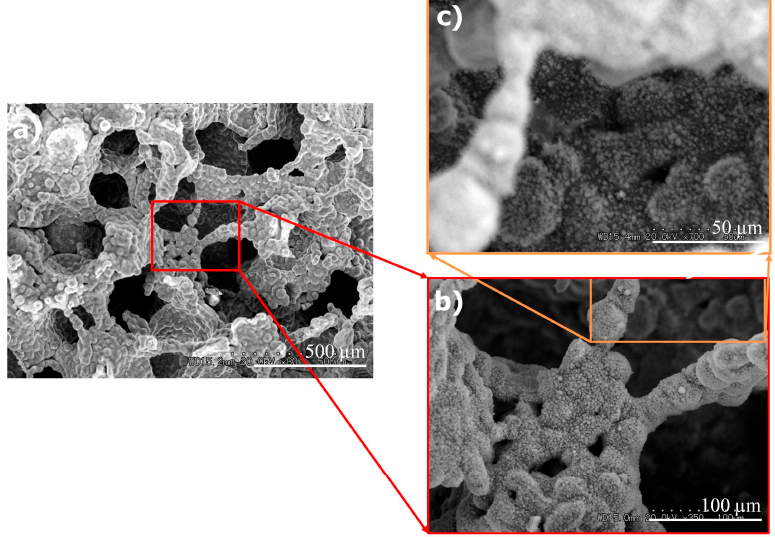
Figure 4. Scanning electron microscopy (SEM) images of Porous ‐ Ti ‐ AT ‐ SPT. Fine spherical hydroxyapatite (HA) particles were uniformly precipitated over the entire surface ( a ), the areas recessed in the shape of the porous structure ( b ), and inner surface of the pores ( c ).